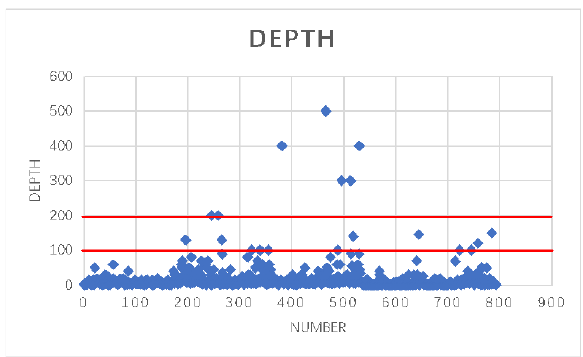
Figure 16. The three section of the cracks’